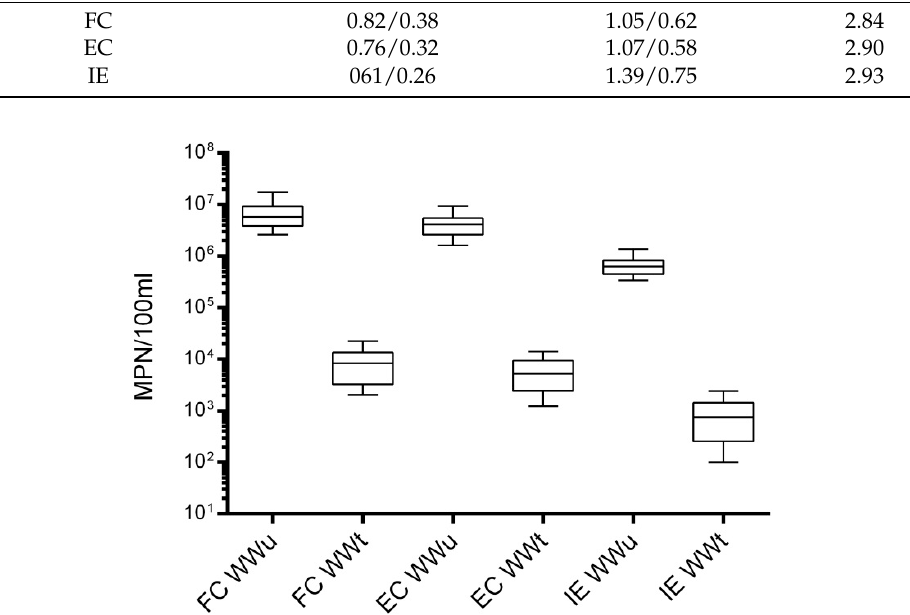
Figure 1. Number (MPN/100 mL) of FC, EC und IE in the untreated wastewater (WWu) and in the treated wastewater (WWt) (annual average, 90th percentile, p = 0.0001). Values are presented in a box